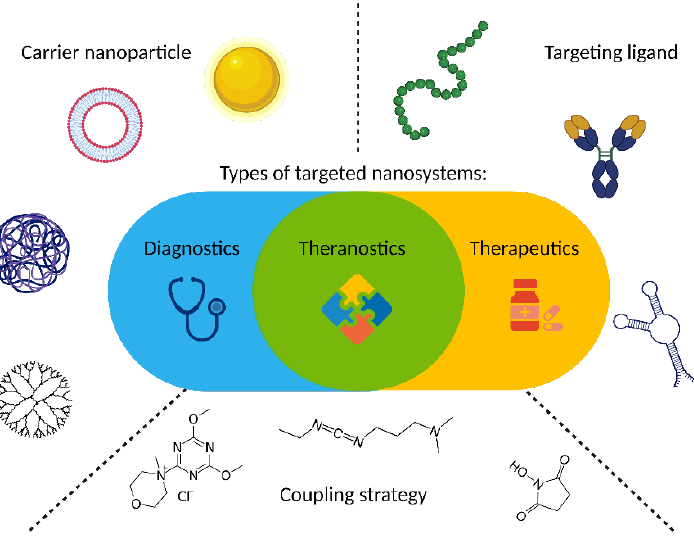
Figure 3. Targeted nanosystems may perform different roles, but, fundamentally, three major aspects, carrier nanoparticle, targeting ligand, and means of bringing them together, must be fine-tuned to yield successful formulation. Created with BioRender.com.